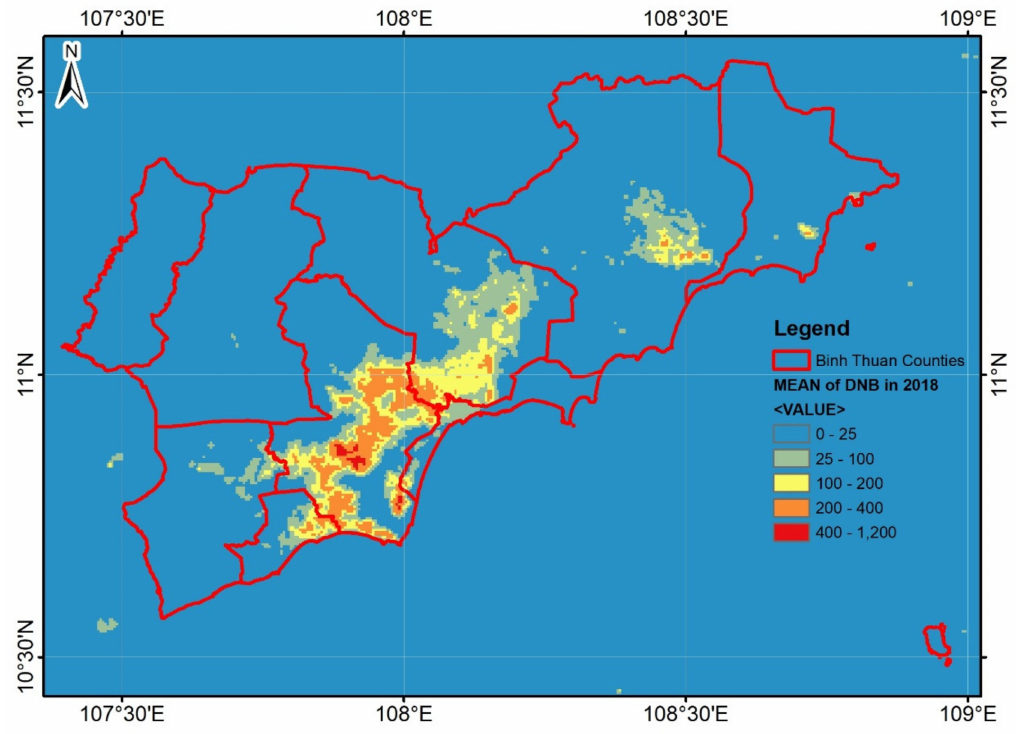
Figure 5. The spatial distribution of NTL brightness of Binh Thuan Province in